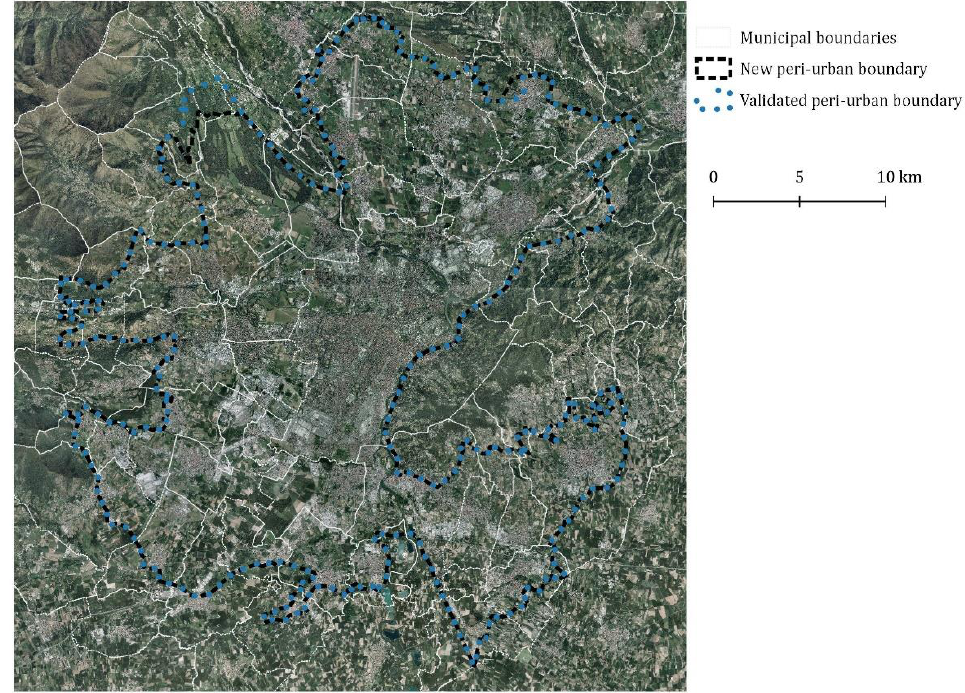
Figure 4. The perimeter of the Turin peri-urban area in relation to the discontinuity cells within protected areas and taking into account the altimetry and the terrain slope (secondary conditions for peri-urbanization).